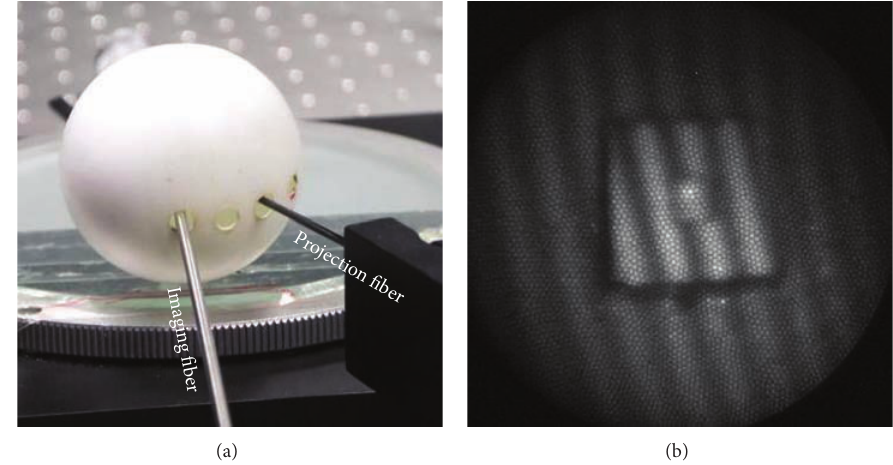
Figure 8: Closed-space scenario. (a) Several holes were created on the surface of the ping pong to provide access for the fibers. (b) A fringe pattern recorded by the camera. Zooming in the picture, one can see the image of lots of individual fiber ends.